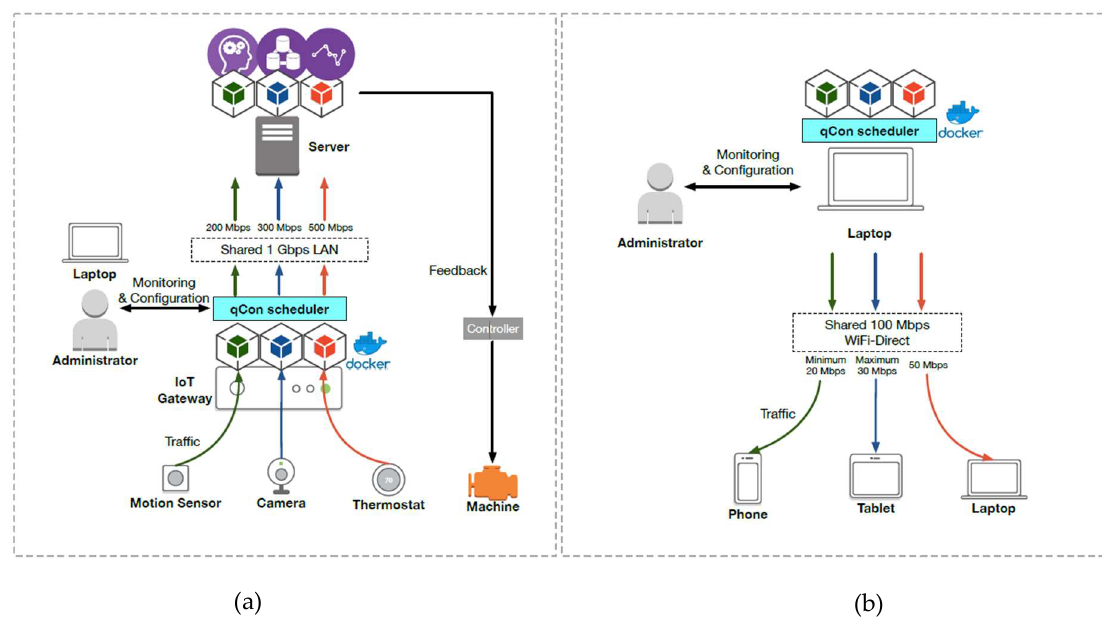
Figure 1. Use cases of qCon ( a ) in a smart factory and ( b ) in fog computing using mobile devices. IoT: Internet of Things; LAN: local area